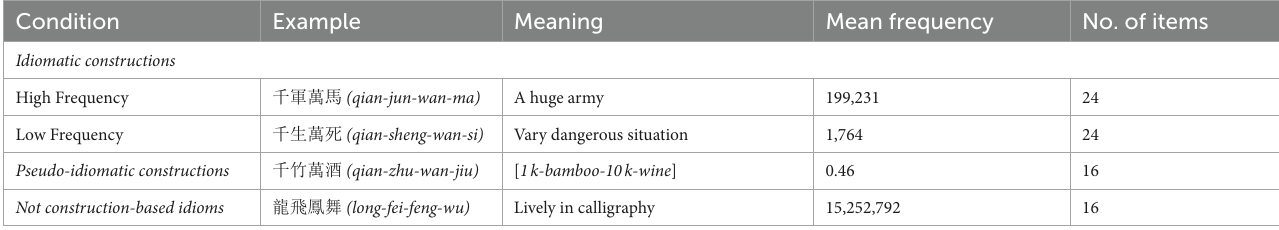
TABLE 1 Examples of trials in the experiment.